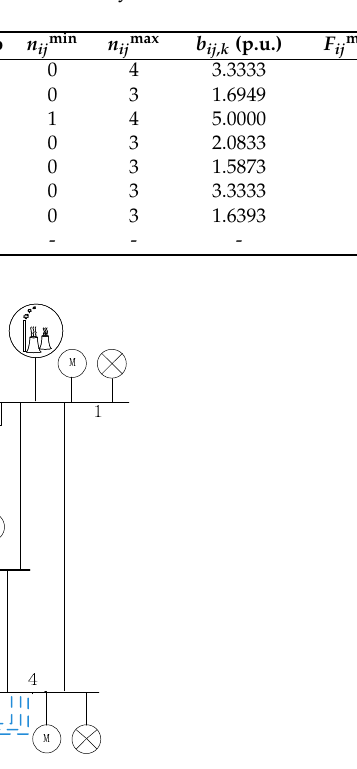
Table 1. Branch parameters for Garver’s 6-bus system.